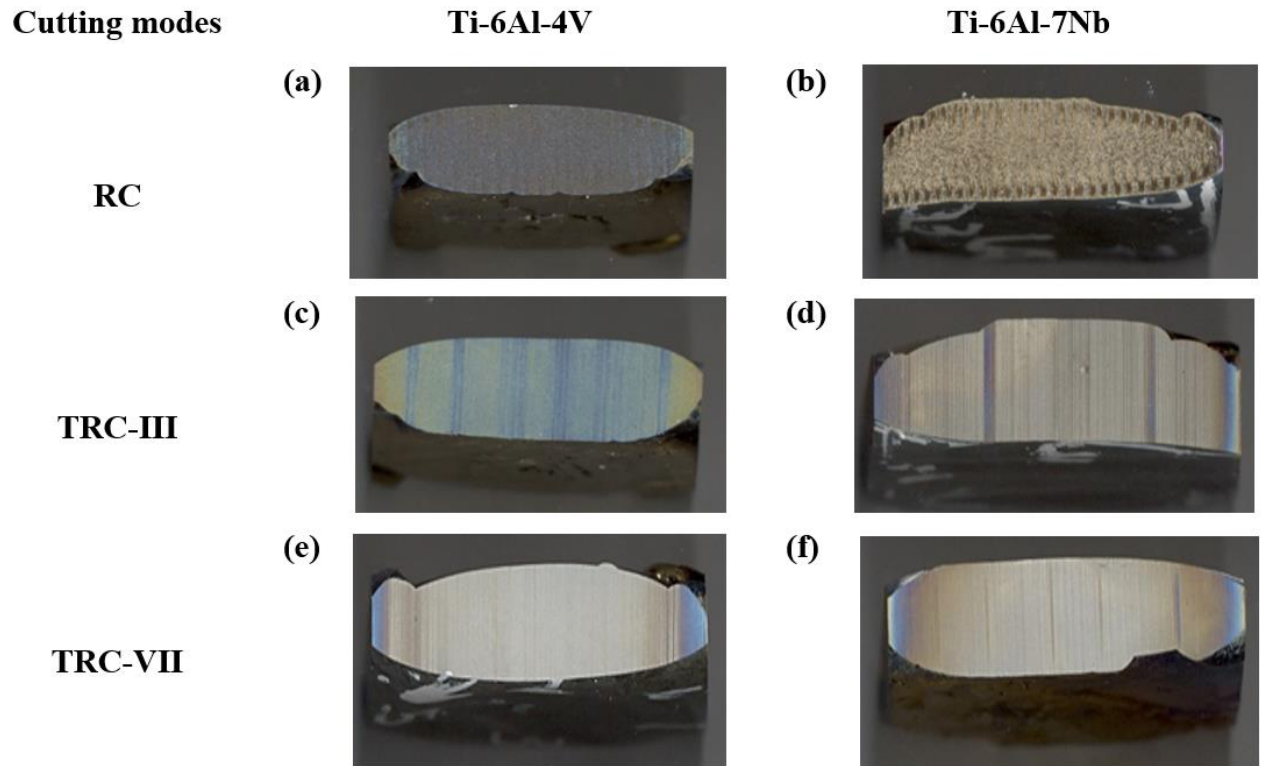
Figure 7. Images of machined surfaces at different cutting conditions.